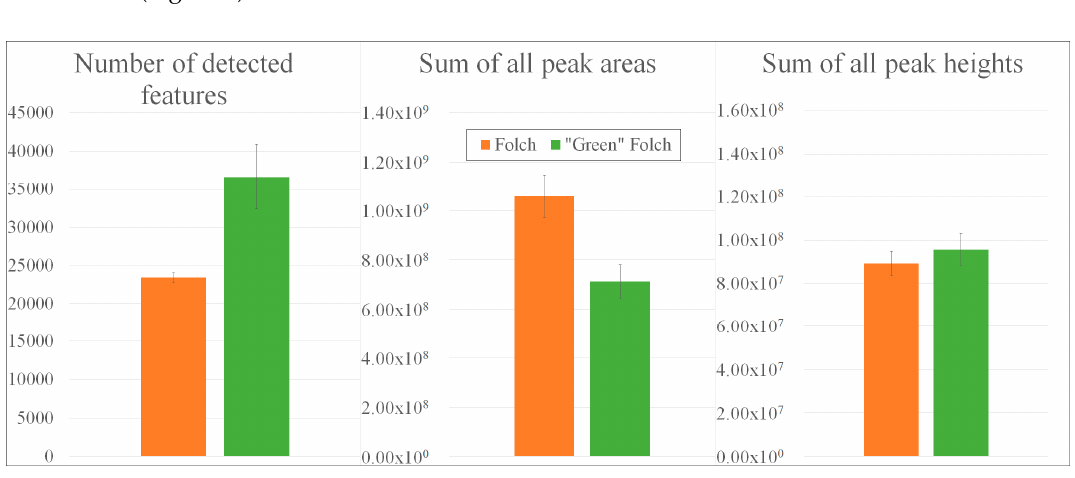
Figure 5. Comparison of extraction procedures according to Folch [23] versus a “green” Folch approach [27] with regard to the number of detected mass features, the sum of all peak areas, and the sum of all peak heights.